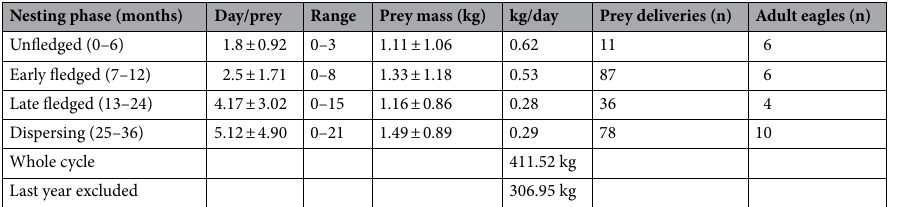
Table 1. Prey delivery rates of harpy eagles per nesting phase. The four phases represent different stage on which eaglets (and adult females, in case of early-unfledged eaglets) receive prey on the nest. Since eagles > 24 months frequently eat prey out of the nest, and hunt independently, those were removed from input calculation. Prey delivery rates (day/prey) and biomass delivery rates (kg/day) are shown in mean ± SD. Range represents the number of days between prey deliveries, with 0 days representing two deliveries on a single day.